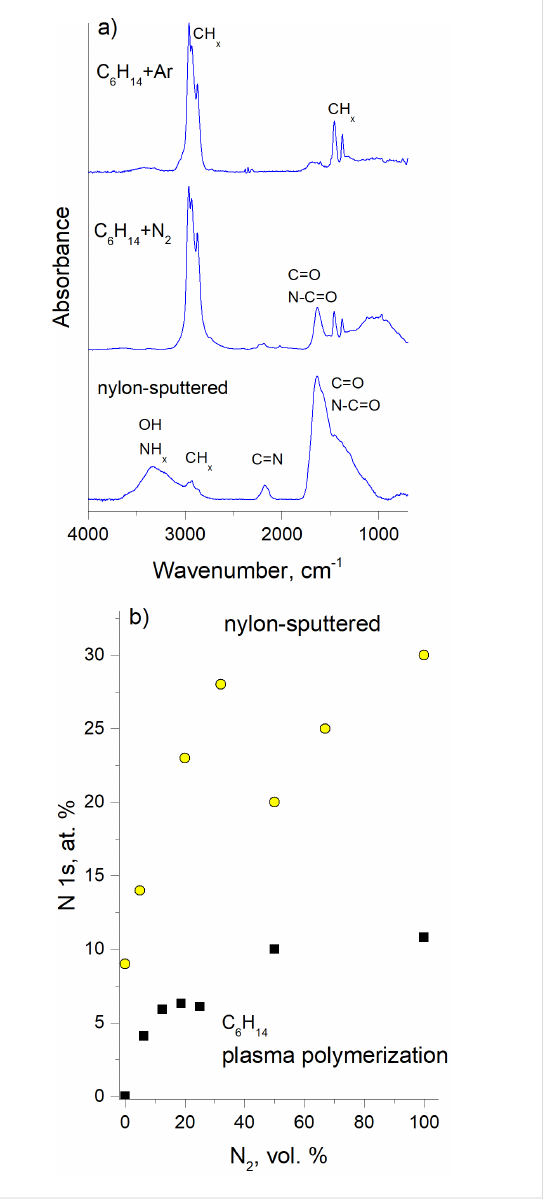
Figure 6: Chemical composition of nitrogen-containing NPs shown in Figure 5: a) FTIR spectra; b) the nitrogen content calculated from the XPS spectra as a function of the N 2 concentration in the working